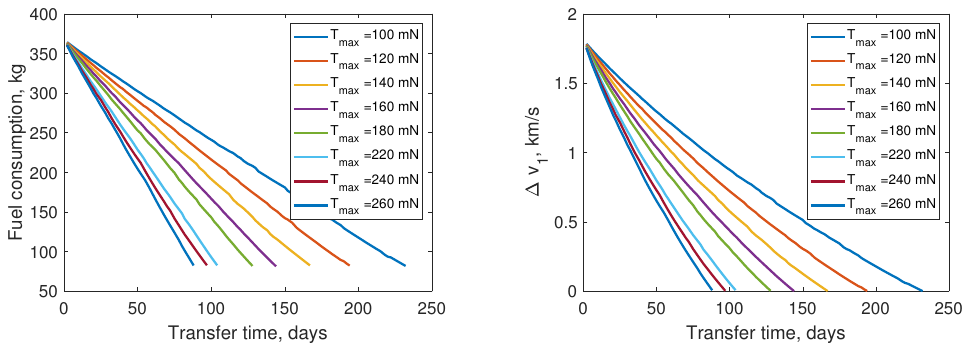
Figure 10. The variation in fuel consumption with transfer time and variation in magnitude of impulsive burn with transfer time for different values of T max when I sp = 2500 s.